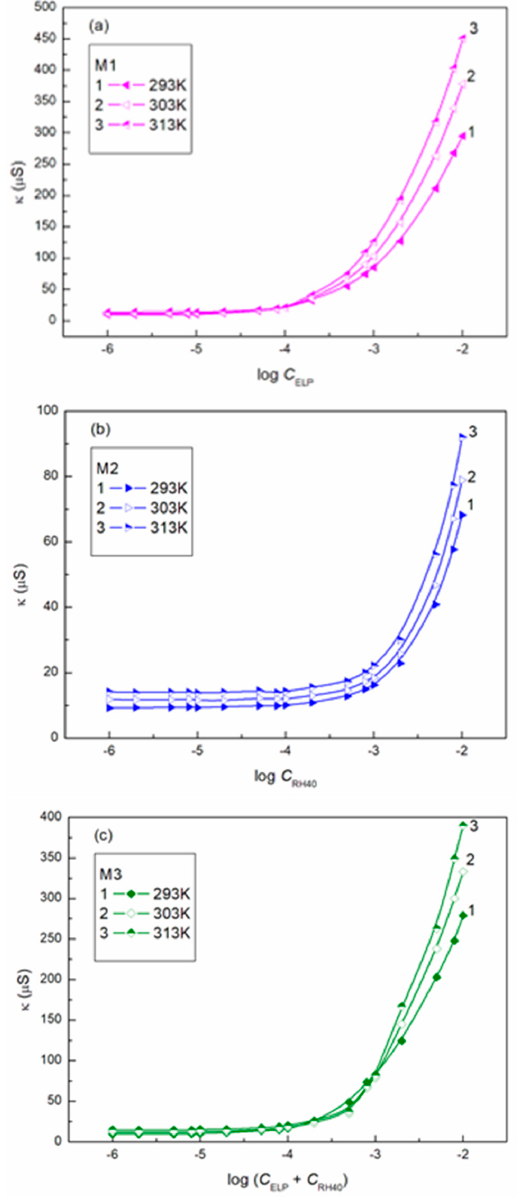
Figure 5. A plot of the specific conductivity ( κ ) of mixtures M1 ( a ), M2 ( b ), and M3 ( c ) vs. the logarithm of the surfactant or their mixture concentrations at a constant temperature equal to 293 K (curve 1), 303 K (curve 2) and 313 K (curve